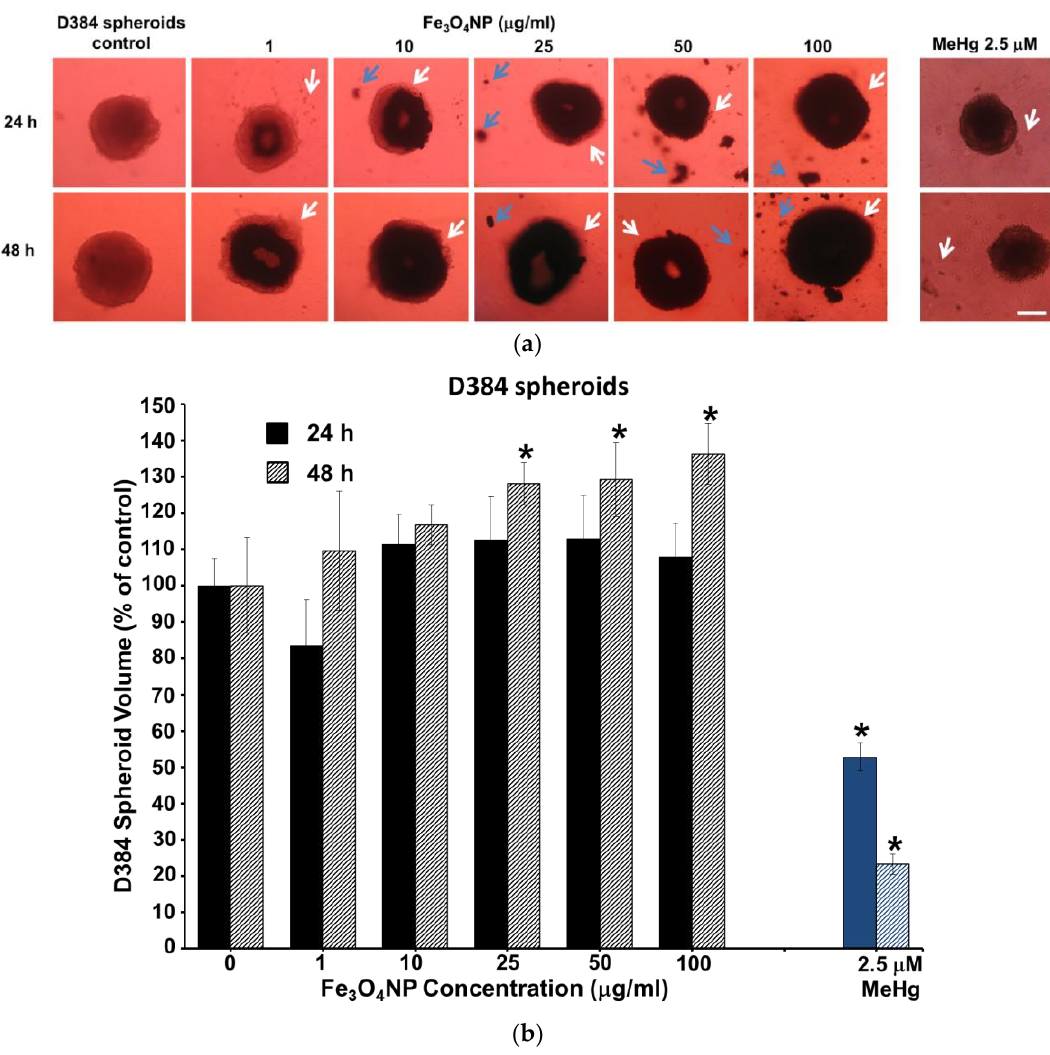
Figure 4. Morphology and volume of astrocyte spheroids after short-term treatment with Fe 3 O 4 NPs: ( a ) Bright-field images of D384 spheroids, washed with PBS, exposed to increasing concentrations of Fe 3 O 4 NPs after 24 and 48 h. White arrows indicate spheroid disaggregation and blue arrows indicate outside sediments of Fe 3 O 4 NPs. Scale bar: 100 μm; ( b ) Bar chart showing the volume growth (% of control) of D384 spheroids formed after 24 and 48 h, with error bars representing standard deviation of the mean ( n = 4). * p < 0.05, statistical analysis by two-way ANOVA followed by Dunnett’s test.